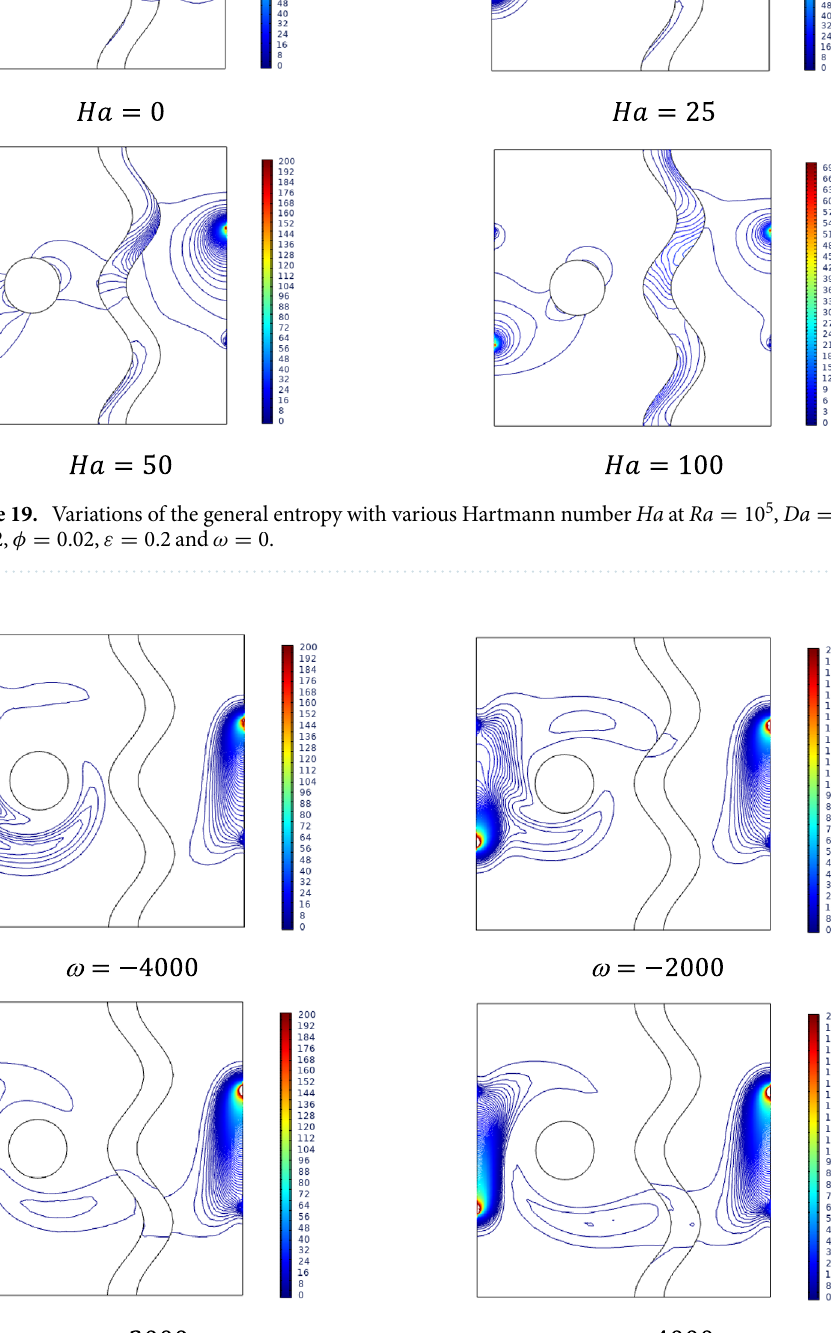
Figure 20. Variations of the general entropy with various rotational speeds ω at Ra 0.4 and Da 0.02 , ε φ = =